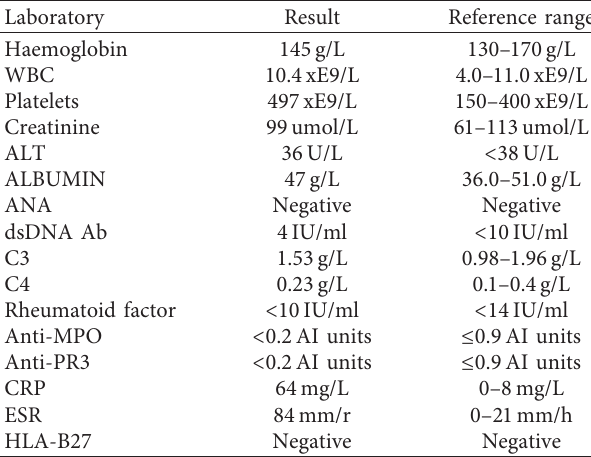
Figure 1: Skin lesions (papular, maculopapular, and urticaria-like rash) involving left (a) and right (b) forearms in a 39-year-old gentleman with bowel-associated dermatosis-arthritis syndrome (photo taken with written permission). Table 1: Laboratory data during